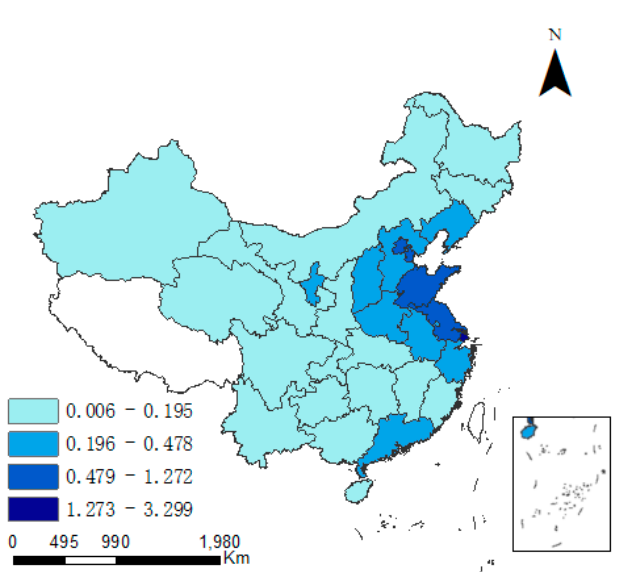
Figure 2. Carbon density in 1997.